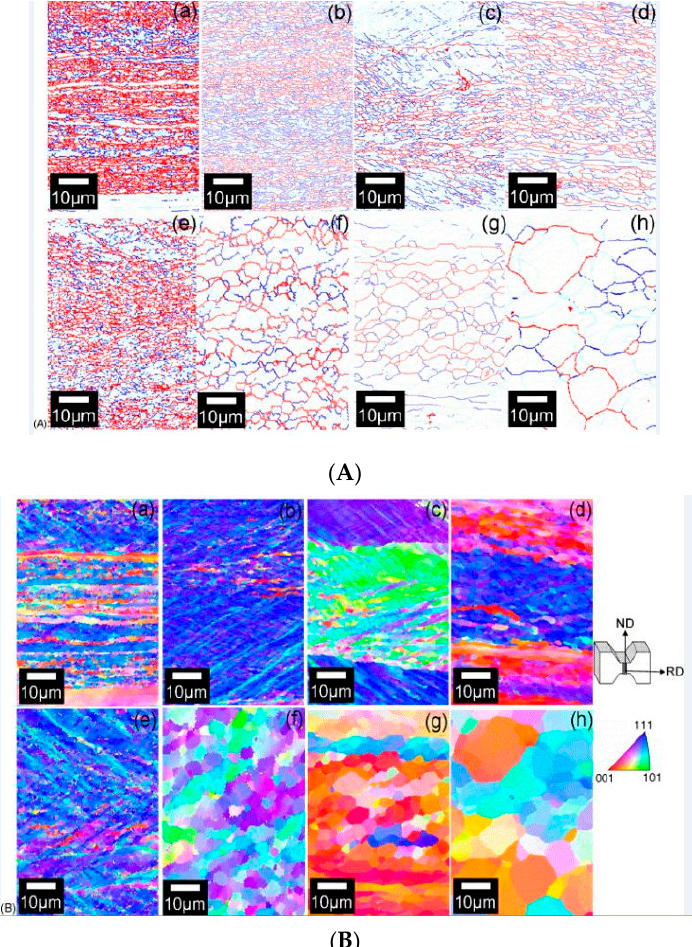
Figure 9. ( A ) Boundary maps of the specimens deformed at a strain rate of 1 s − 1 at ( a ) 823 K, ( b ) 873 K, ( c ) 923 K, ( d ) 973 K, ( e ) 773 K, ( f ) 873 K, ( g ) 923 K, and ( h ) 1023 K observed at a strain of 4 [77] . ( B ) Crystallographic orientation distribution of local regions along the normal direction (ND) obtained